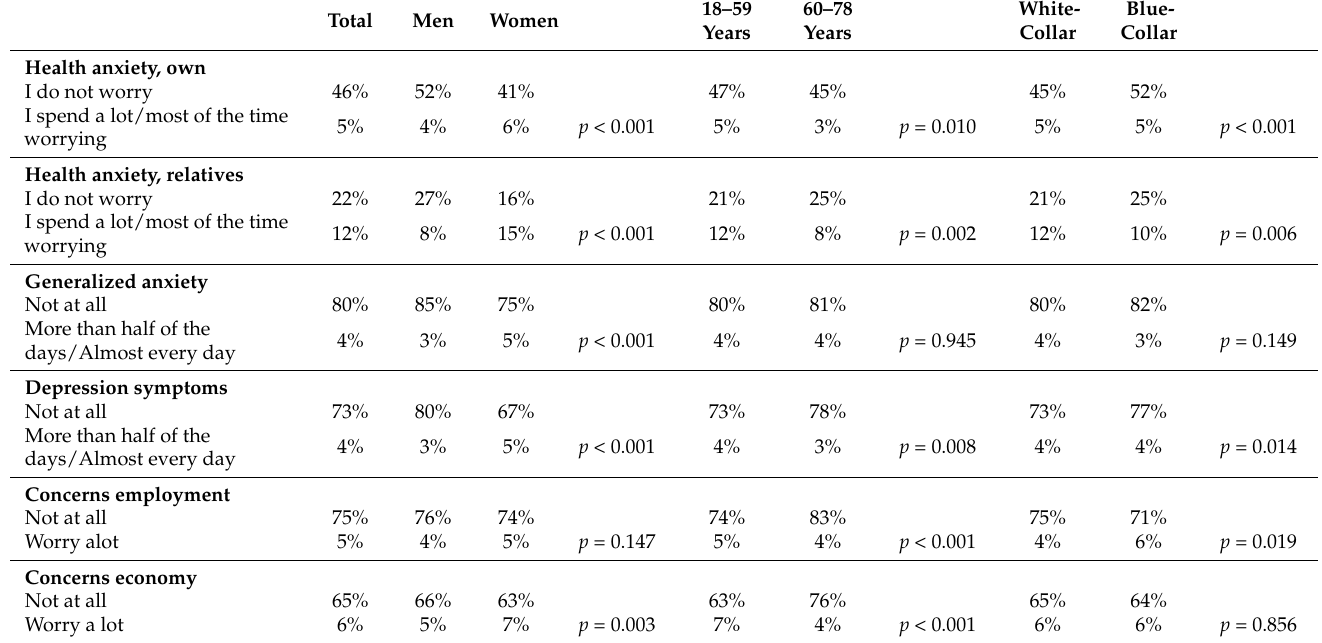
Table 4. Health experiences during the study period in the total population, as well as in relation to sex, age, and occupational